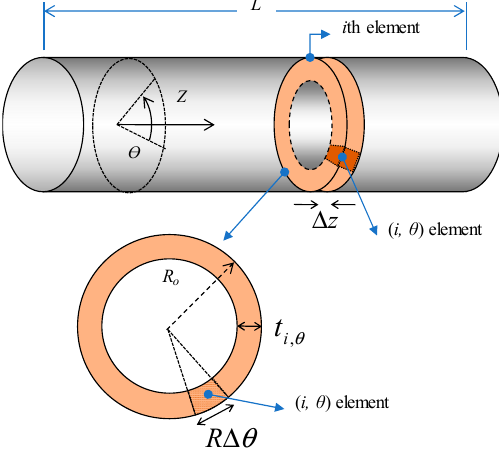
Figure 4. A schematic of tube-type heater for analytical model of temperature distribution.